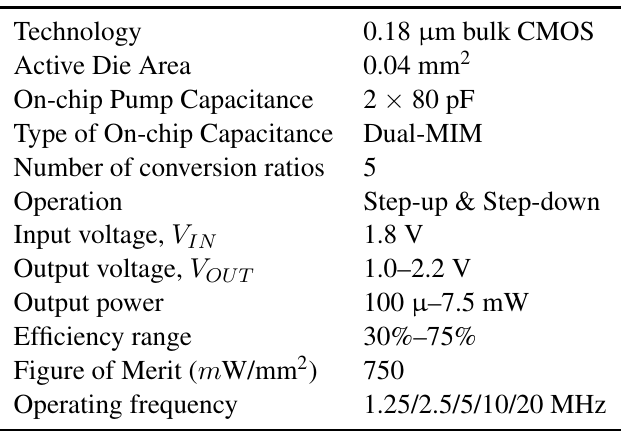
Table 2. Key features of the DC-DC converter.